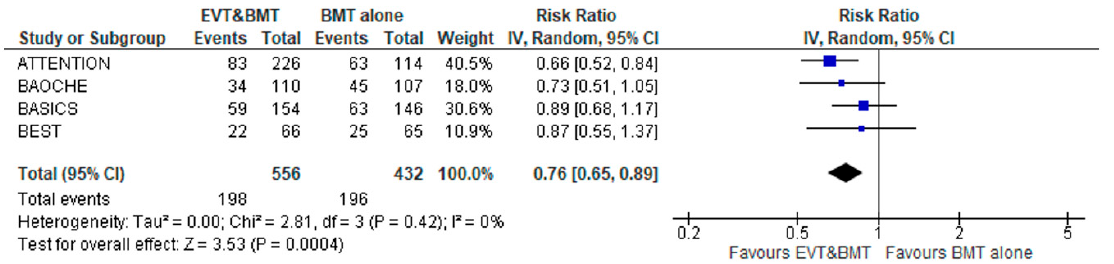
Figure 4. Forest plot presenting the association of endovascular treatment (EVT) combined with best medical treatment (BMT) compared to BMT alone with mortality at 3 months among acute basilar artery occlusion patients.